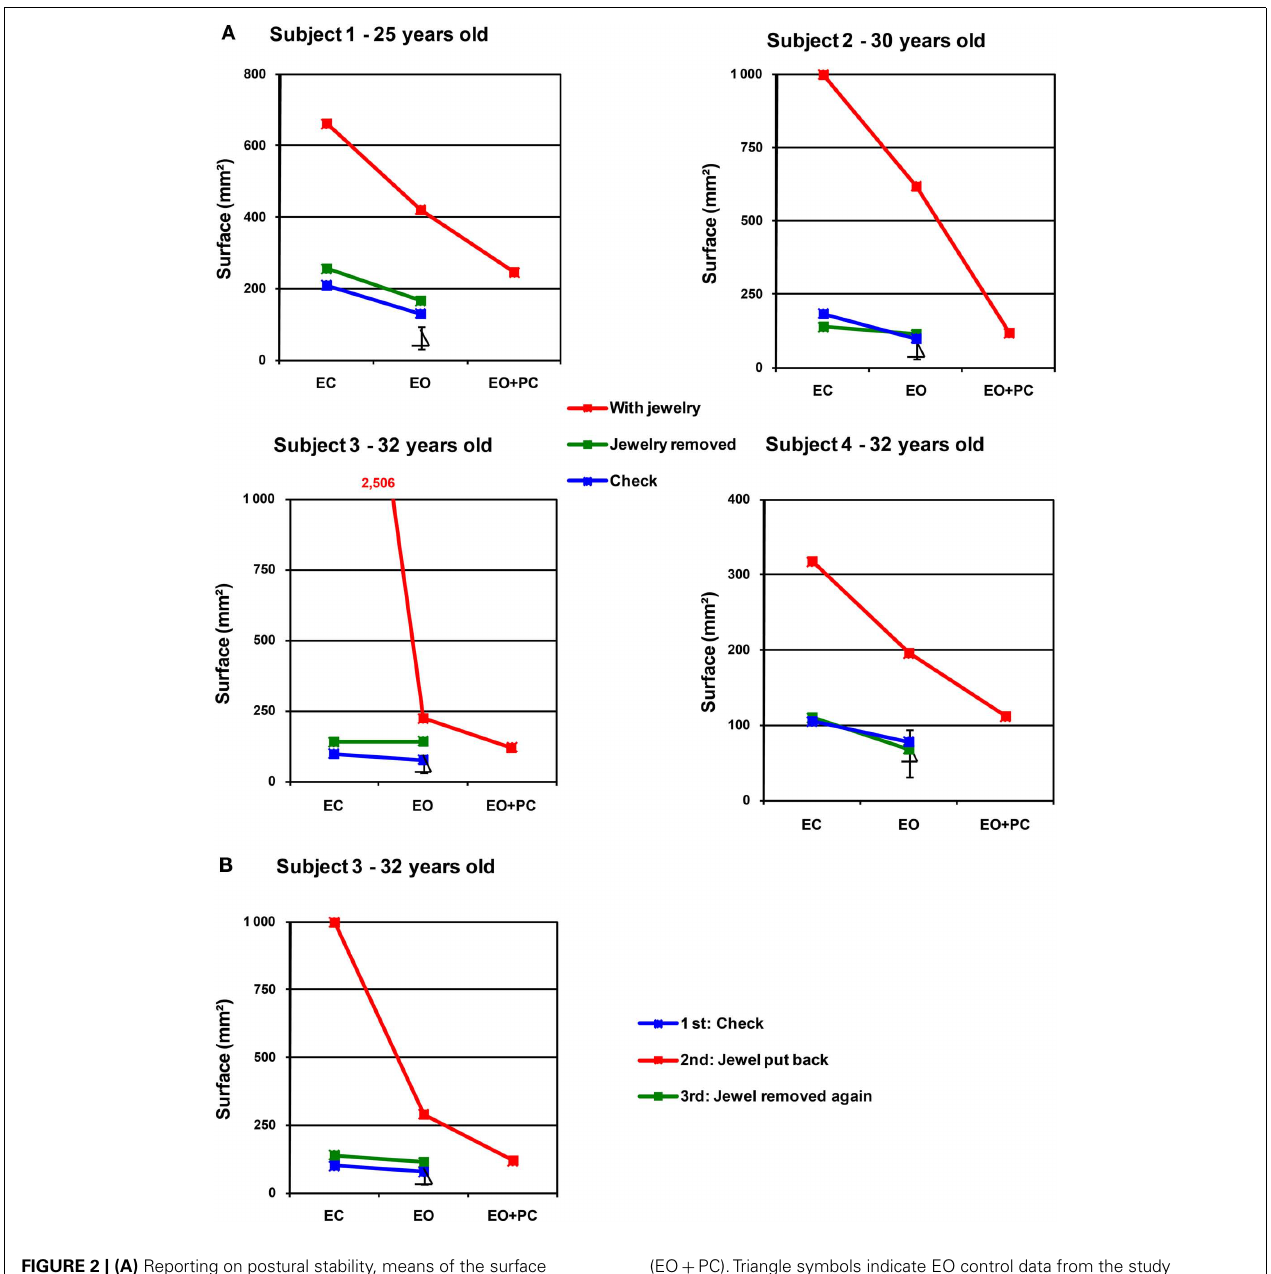
FIGURE 2 | (A) Reporting on postural stability, means of the surface area of the center of pressure excursions (mm 2 ) for each subject for each condition with jewelry, when jewelry is removed and when on average 3weeks later the check is done. Eyes open (EO), eyes closed (EC), and EO with a prism to cancel the vertical heterophoria